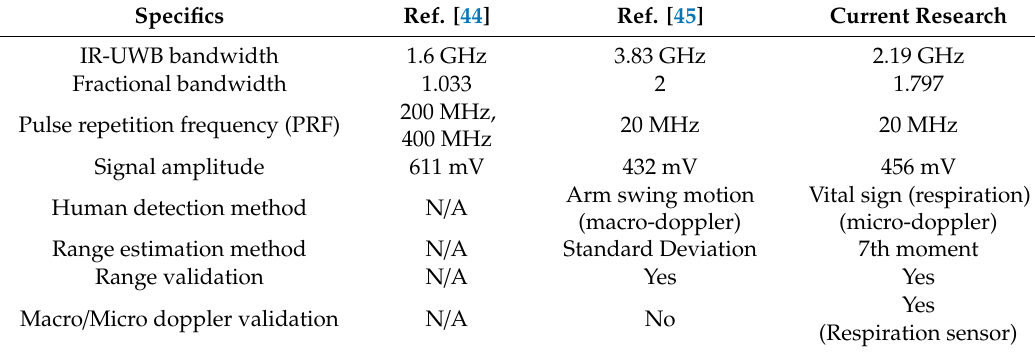
Table 1. Comparison between previous works on impulse-radio ultra-wideband (IR-UWB) technology and this current